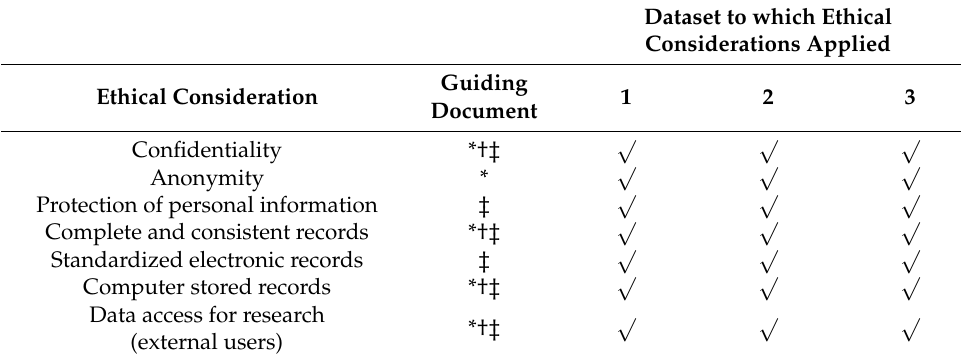
Table 2. Checklist of ethical considerations used from data